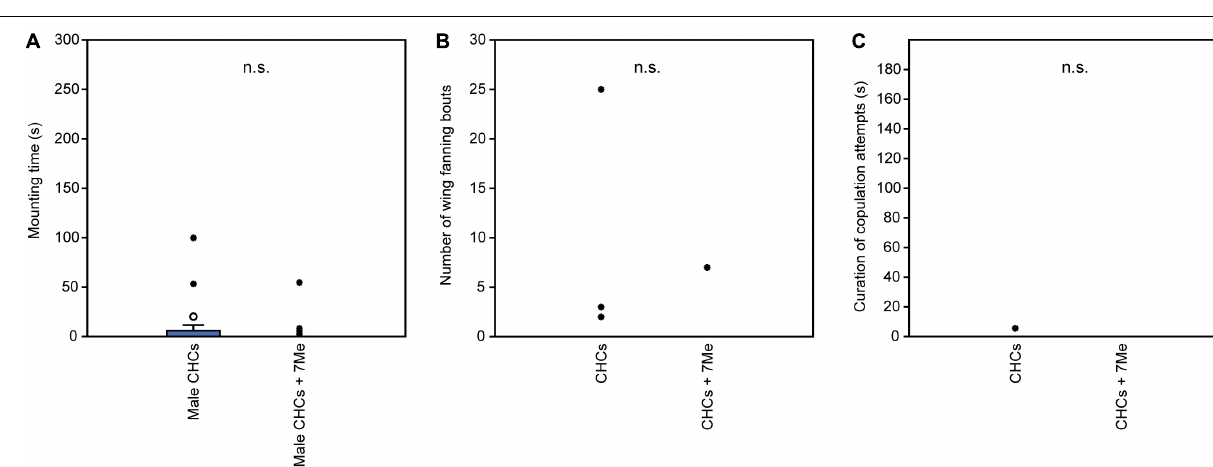
FIGURE 4 | Behavioral responses of U. rufipes males to Soxhlet-extracted male cadavers (dummies) treated with female-derived methyl-branched cuticular hydrocarbons (Me-alkanes) or synthetic n-alkanes (N-alkanes) reconstructed in a female-specific ratio. Control dummies were treated with the pure solvent. Given are (A) the time males spent mounted on the dummy, (B) the number of wing-fanning bouts, and (C) the duration of copulation attempts. Box-and-whisker plots show median (horizontal line), 25–75% quartiles (box), maximum/minimum range (whiskers) and outliers ( ◦ > 1.5 × box height; • > 3 × box height; Kruskal-Wallis H -test, n.s. = not significant; n = 25). Statistical results are given in detail in Supplementary Table S3 .